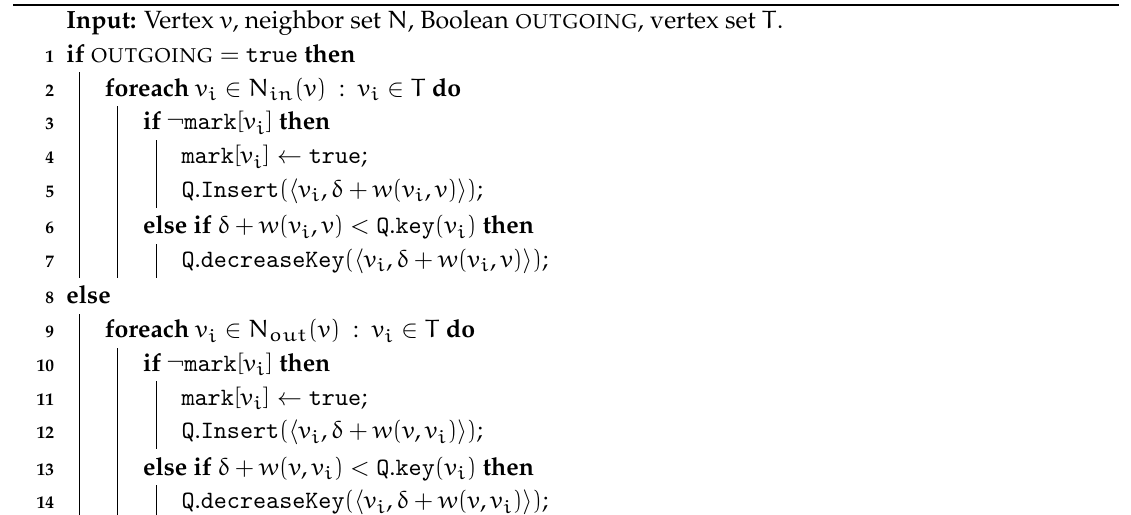
Algorithm 8: Procedure PRUNED R ELAX used by Algorithm